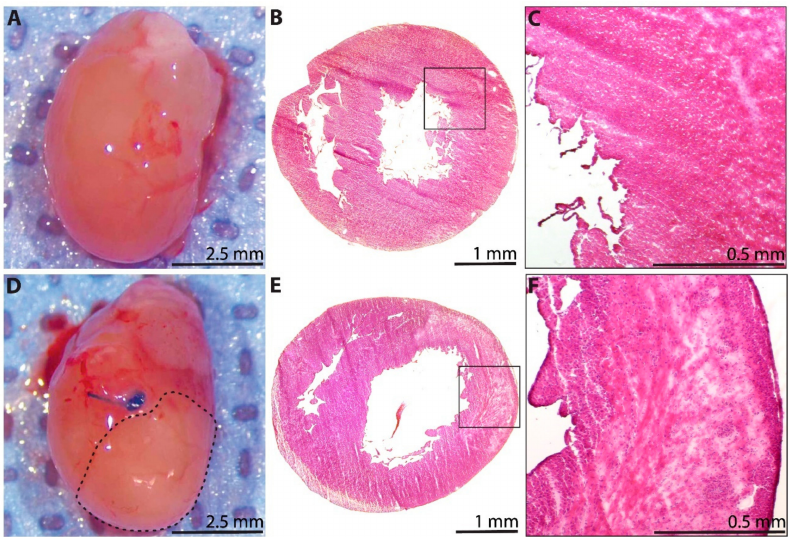
Figure 2. Histological assessment of the neonatal rat heart at 1 day after sham surgery or induction of myocardial infarction (MI) on postnatal day 1. ( A ) Explanted heart from the sham group. ( B ) Hematoxylin and eosin (H&E)-stained section from the sham group ( n = 3), with ( C ) inset showing healthy myocardium, as well as a limited area of minor tissue injury from needle trauma during sham surgery (upper right corner). ( D ) Explanted heart from the MI group, showing a clear region of non-perfused myocardium below the coronary artery ligation suture (dotted line). ( E ) H&E-stained section from the MI group ( n = 3), with ( F ) inset showing widespread areas of acute inflammatory infiltrate, severe ischemic necrosis, and tissue edema within the affected